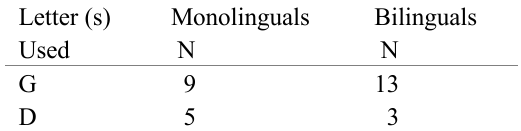
Table 14. Misspellings for the phoneme / ʤ / in